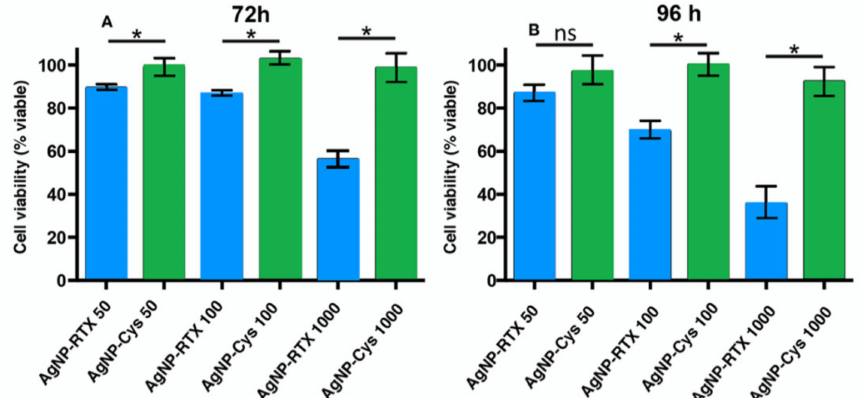
Figure 3. Behavior of the A549 cells after treatment with AgNP-Cys (green bar) and AgNP-Cys-RTX (blue bar) at different time periods ( A ) 72h ( B ) 96h and concentrations. The NP concentrations are expressed as nM of RTX. Each bar represents the mean +/ − SEM of three independent experiments performed in triplicate normalized to non-treated cells (taken as 100%). Differences were analyzed preforming an ANOVA followed by a Newman–Keuls multiple comparison test. * p -value < 0.05; ns—no significant.